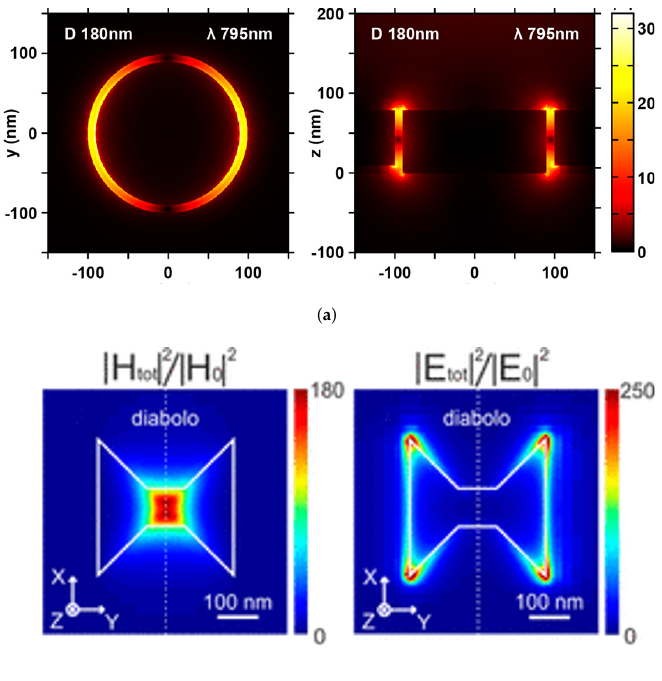
Figure 14. Field confinement in plasmonic nano-traps (from left to right): ( a ) Horizontal (taken 1 nm below the metallic surface) and vertical electric field distributions for a 180 nm inner diameter aperture. Reprinted with permission from [90]. Copyright (2018) American Chemical Society. ( b ) Normalized magnetic and electric intensity distributions in the case of the diabolo nano-antenna. The distributions are plotted in an xy-transversal plane, 10 nm away from the antennas. Adapted with permission from [91]. Copyright (2015) American Chemical